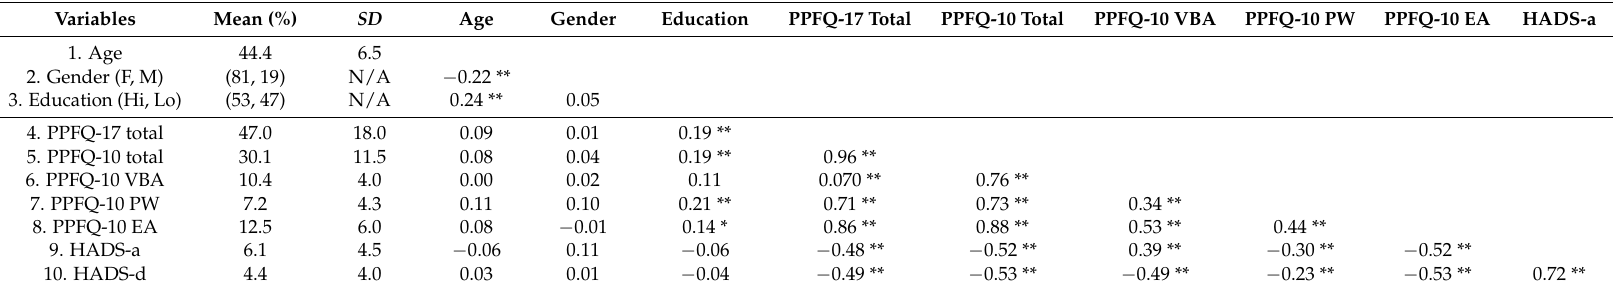
Table 3. Descriptive statistics and correlations between controls and variables of sample ( n = 263).